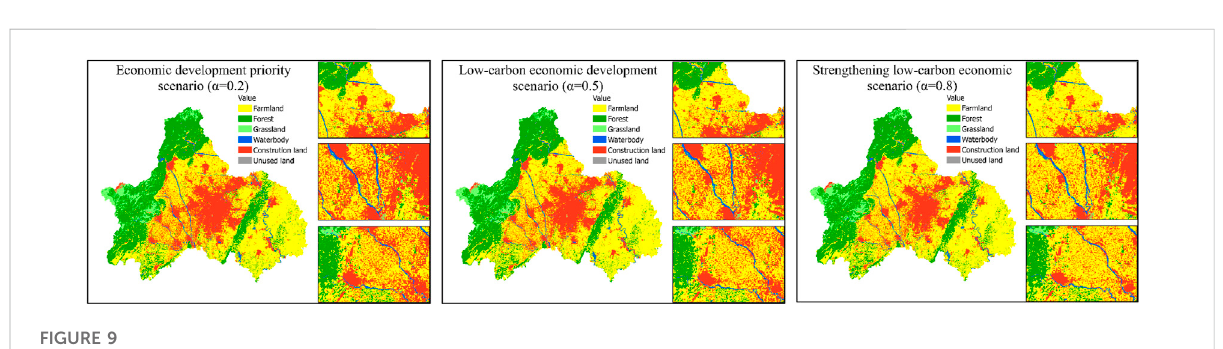
FIGURE 9 Simulated distribution of land use types under three